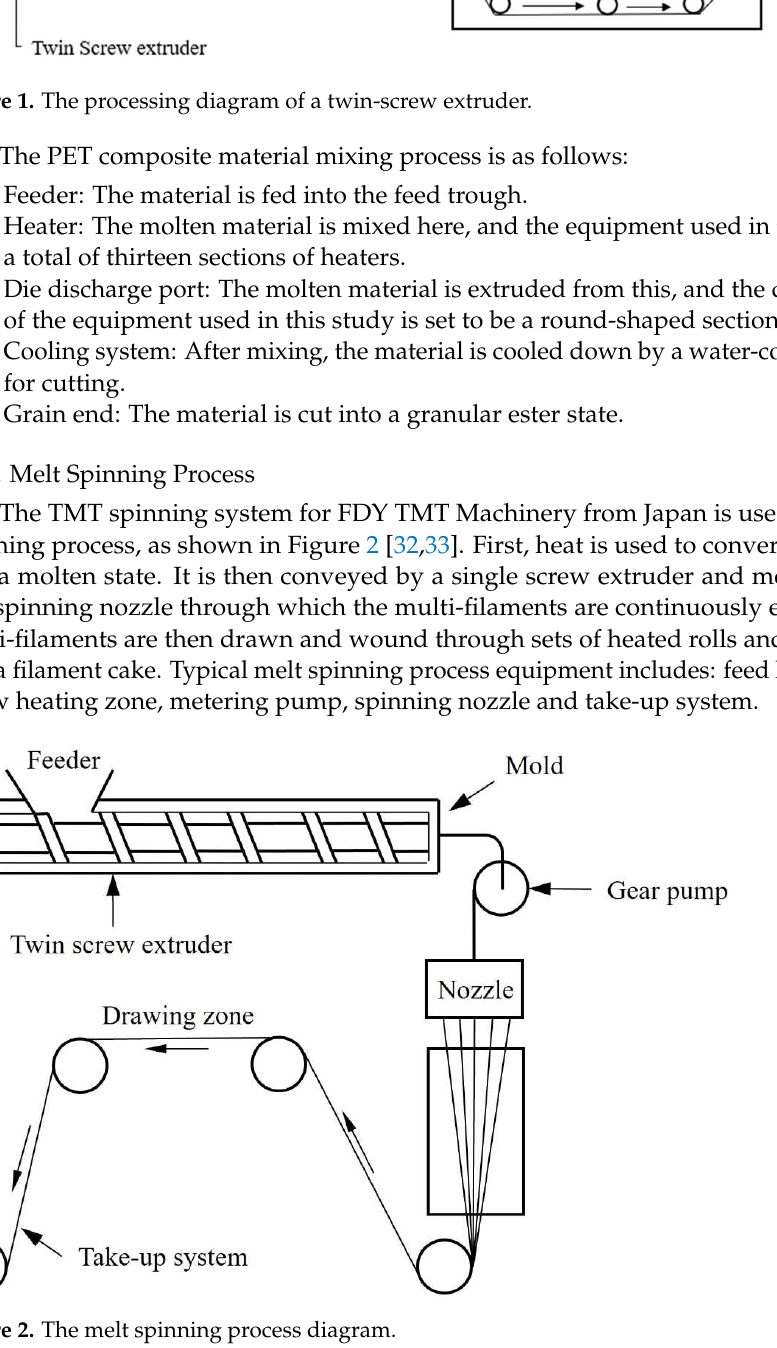
Figure 2. The melt spinning process